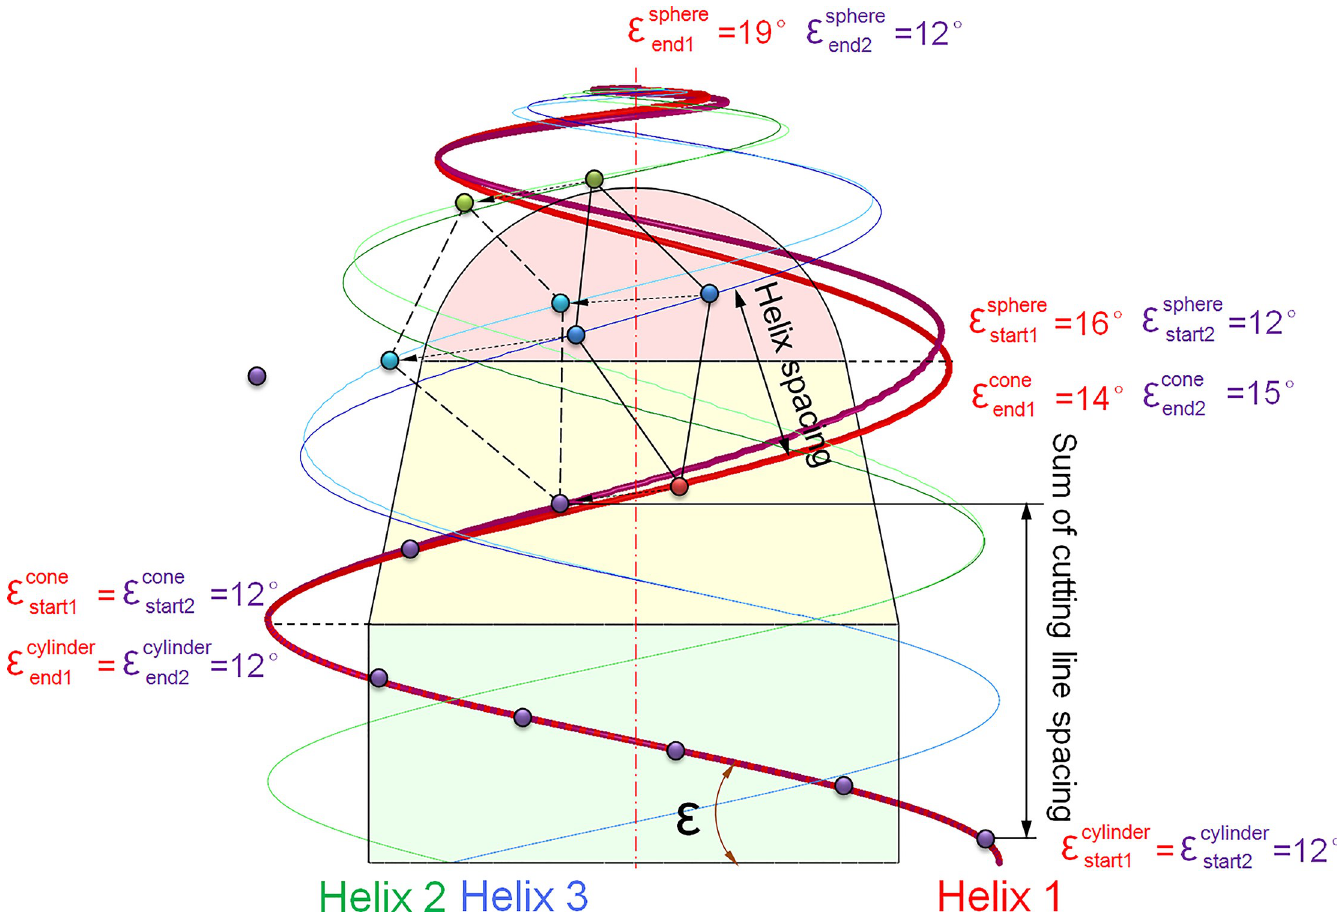
Fig 6. Traversal algorithm block diagram of pick